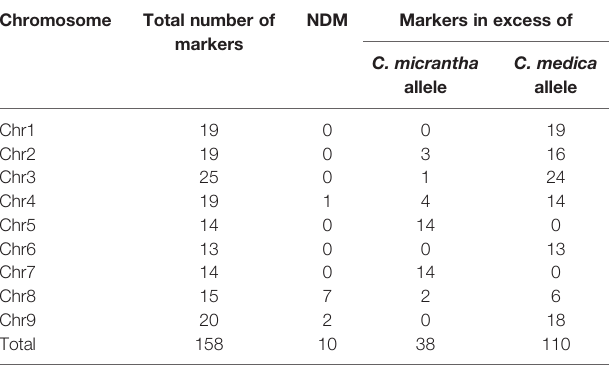
TABLE 2 | Number of markers per chromosome with excess for C. micrantha or C. medica alleles; analysis based only on the homozygous gametes for the considered SNP.